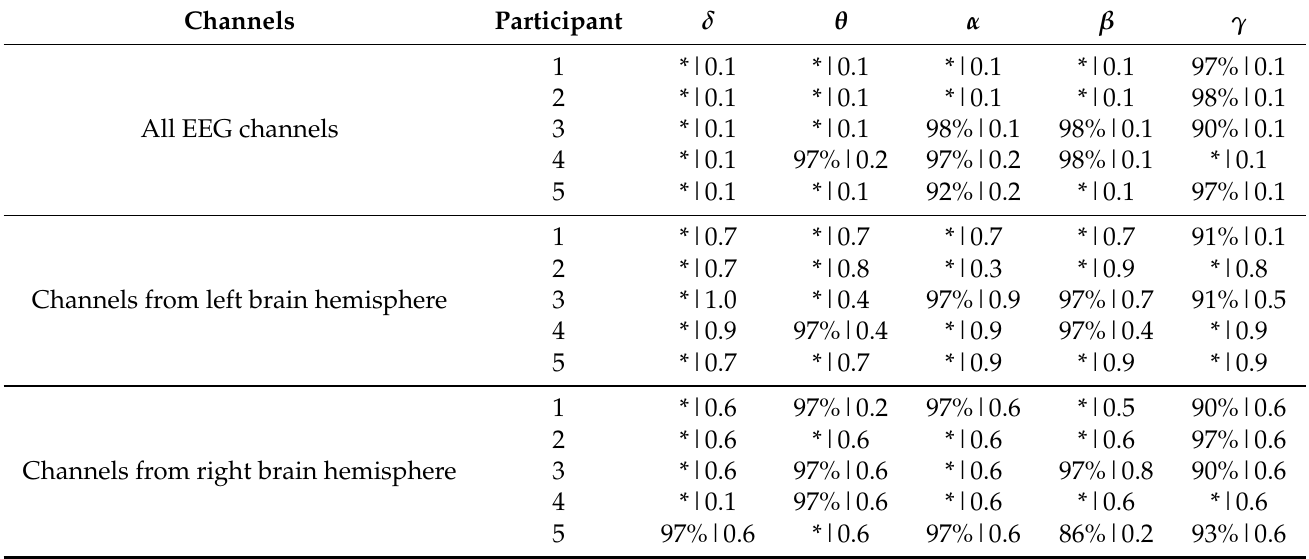
Table 5. The results of classification by deep learning model for Case Study I for Necker cube dataset when we use (first row) all EEG channels, (second row) the channels from only the left hemisphere of the brain, and (third row) the channels from only the right one. The first value for each “cell” is accuracy (* means 100%), and the second one is the intensity, which gives the maximum influence on the